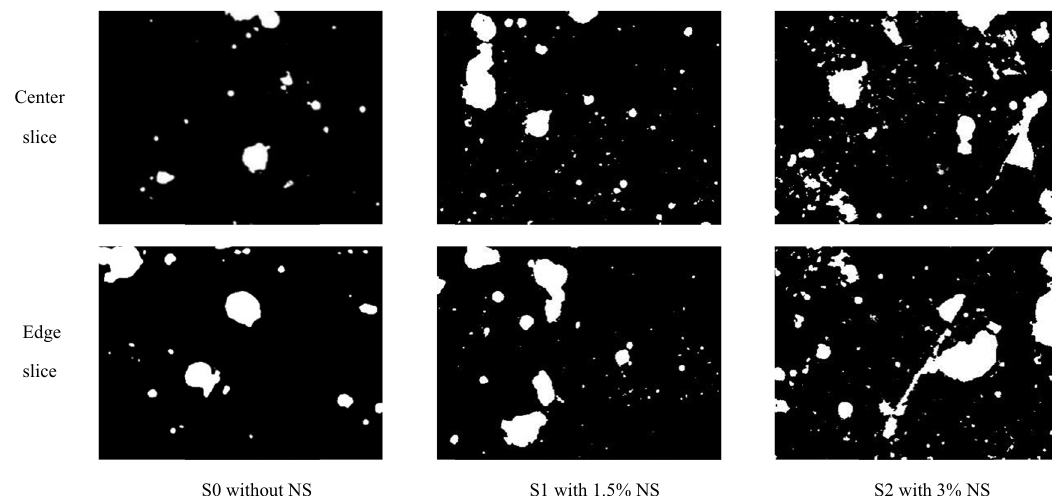
Figure 9: Binary images of sample pore